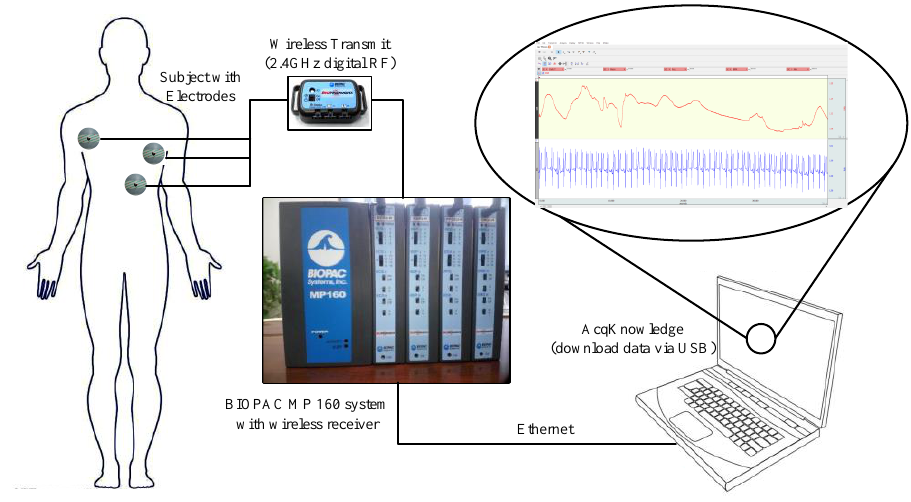
Figure 3. The installation and data processing of the BIOPAC MP 160 data acquisition system.